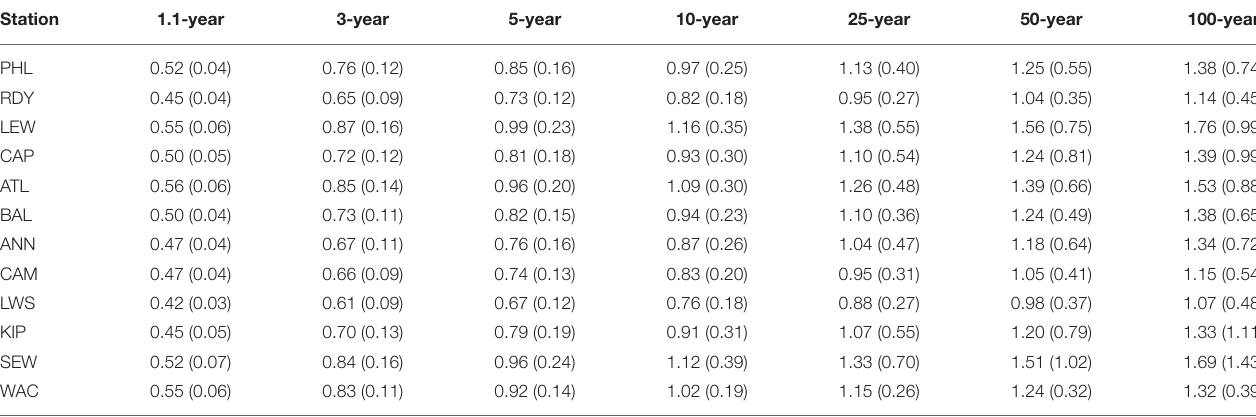
90% confidence intervals in parentheses.